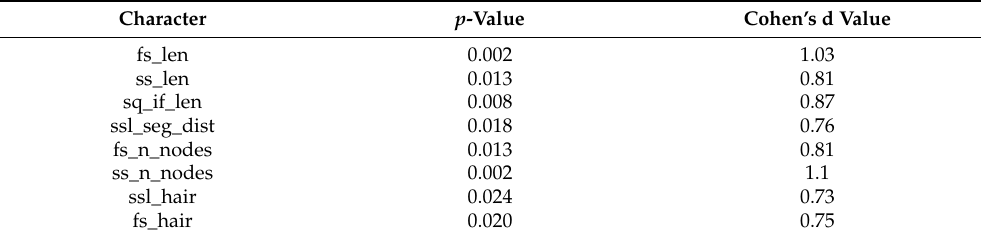
Table 1. The results of univariate analyses contrasting the two cytotypes of the polyploid Spanish endemic Santolina villosa . In this case, fs_len = length of the flowering stem (cm), ss_len = length of the non-flowering stem (cm), sq_if_len = length of the inter-floral bract (mm), ssl_seg_dist = distance between the segments of the non-flowering stem leaf (mm), fs_n_nodes = number of nodes of the flowering stem, ss_n_nodes = number of nodes of the non-flowering stem, ssl_hair = degree of tomentosity of the non-flowering stem leaf segment (%), and fs_hair = degree of tomentosity of the flowering stem (%).